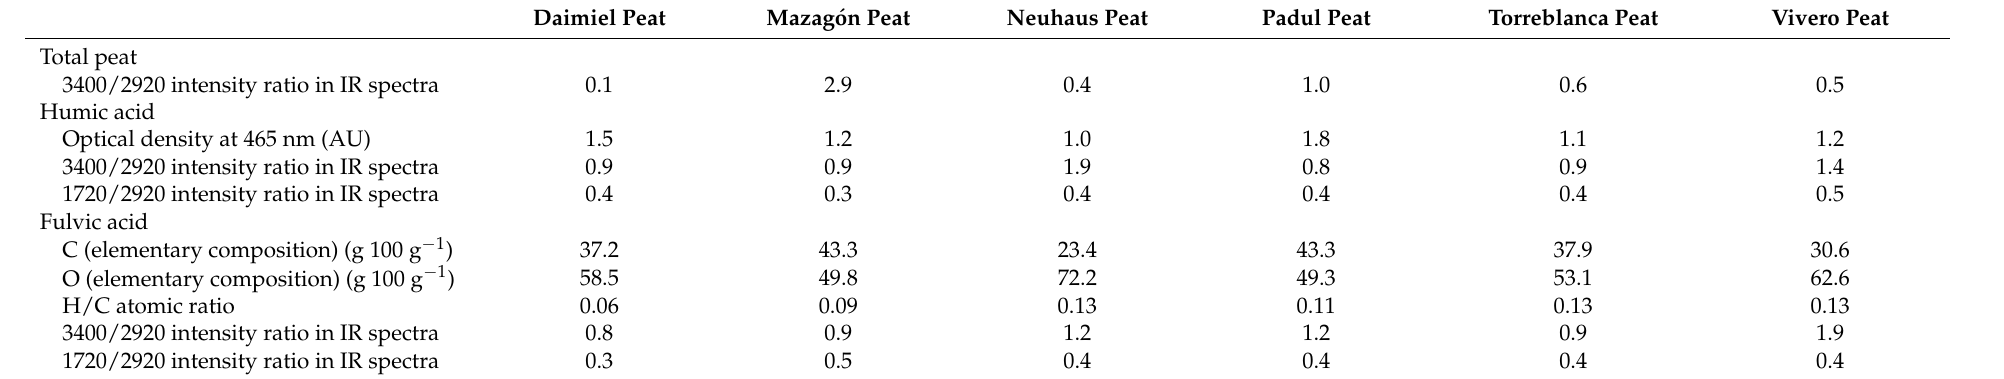
Table 3. Chemical and spectroscopic characteristics of peats and their humic acid and fulvic acid fractions. Daimiel Peat Mazag ó n Peat Neuhaus Peat Padul Peat Torreblanca Peat Vivero Peat